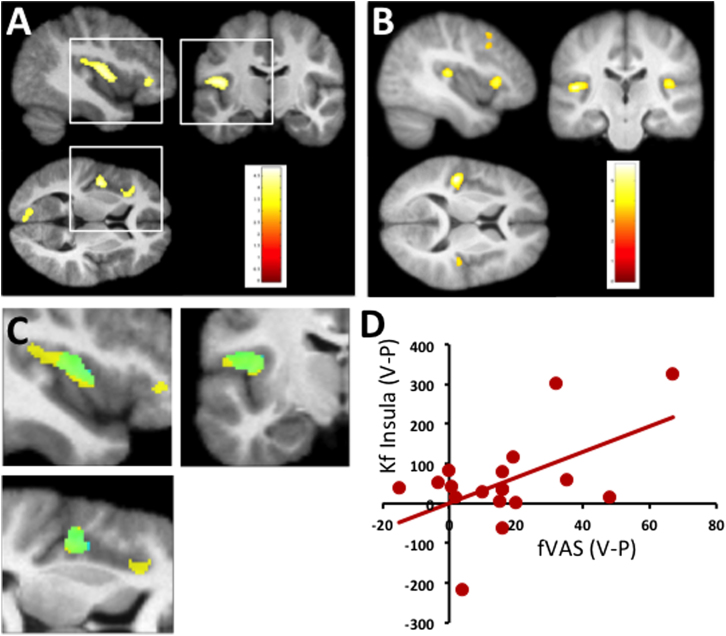
Effects of inflammation on brain structure and function. (A) Quantitative magnetization transfer imaging study. Brain regions showing a significant increase in magnetization transfer exchange rate constant 3–4 hours after typhoid vaccine–induced inflammation compared with control (saline) injection. Data displayed at a whole-brain corrected threshold of p < .05. Color scale denotes t score. (B) Fluorodeoxyglucose positron emission tomography imaging study. Brain regions showing a significant increase in fluorodeoxyglucose uptake 3–4 hours after typhoid vaccine–induced inflammation; exclusively masked by changes in fluorodeoxyglucose uptake 3–4 hours after placebo (mask threshold p < .005). Data displayed at a whole-brain corrected threshold of p < .05. (C) Left insula voxels showing a significant increase in magnetization transfer exchange rate constant 3–4 hours after experimentally induced inflammation (yellow) overlaid with voxels (green) additionally predicting inflammation-induced fatigue (fatigue visual analog scale, p < .05). (D) Correlation of fatigue visual analog scale scores 4 hours after typhoid vaccine minus placebo (V − P) (x-axis) with inflammation-induced changes in magnetization transfer exchange rate constant of all 1196 voxels within the posterior insula cluster (illustrated in yellow in C) on the y-axis (R2 = .2, p < .05). fVAS, fatigue visual analog scale; kf, magnetization transfer exchange rate constant.